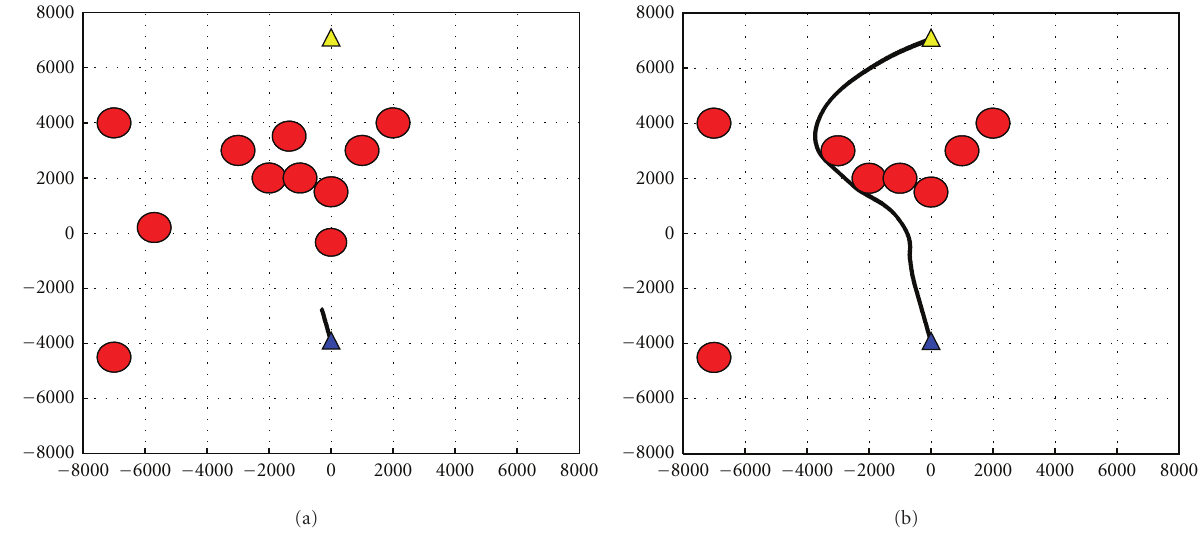
Figure 5: Simulation in crowded dynamic environment P safe = 0 .